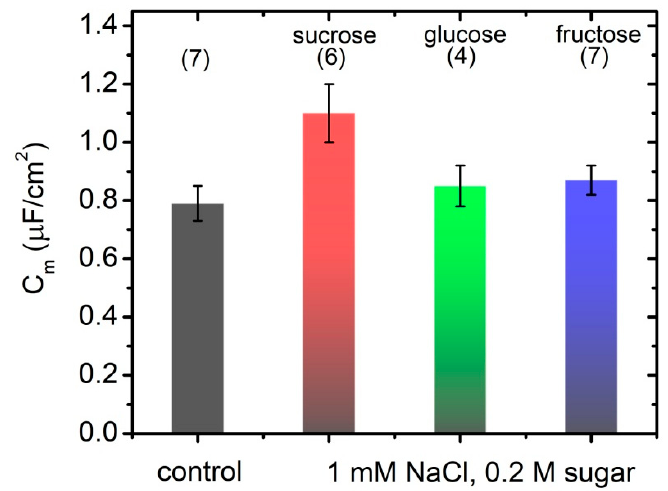
Figure 4. Specific capacitance of POPC BLMs in 1 mmol/L NaCl (control); 1 mmol/L NaCl and 200 mmol/L of sugar (sucrose, glucose and fructose); data acquired by FFT-EIS; C m values calculated as the weighted average of 4–7 independent measurements, each of them averaged over 10 repetitions.